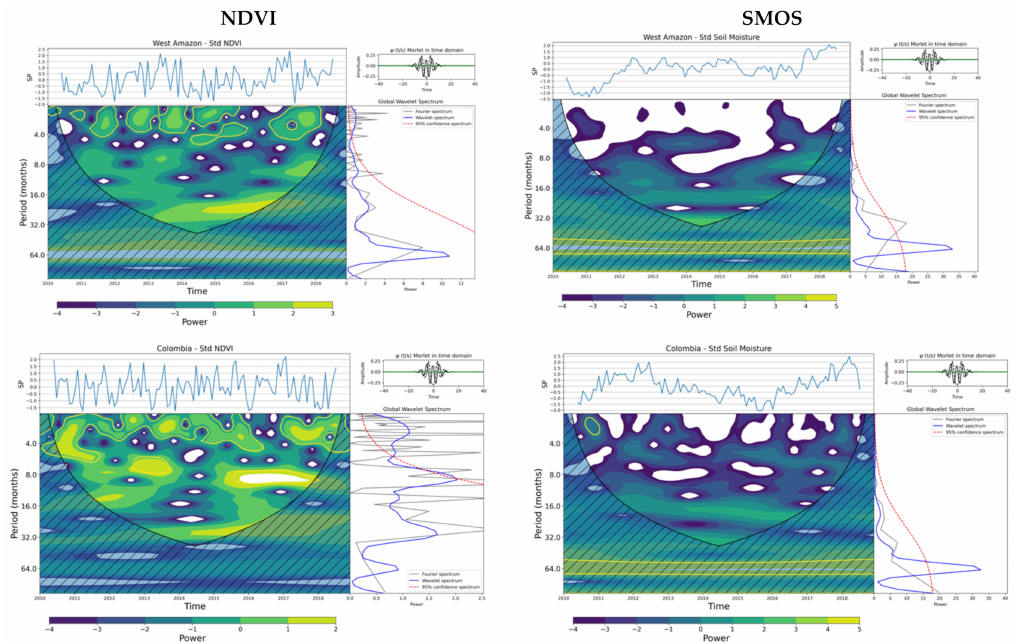
Figure 10. Wavelet transforms of monthly standardized series of regional average values of NDVI ( left panels) and SMOS ( right panels): ( top ) West Amazon and ( bottom ) Colombia